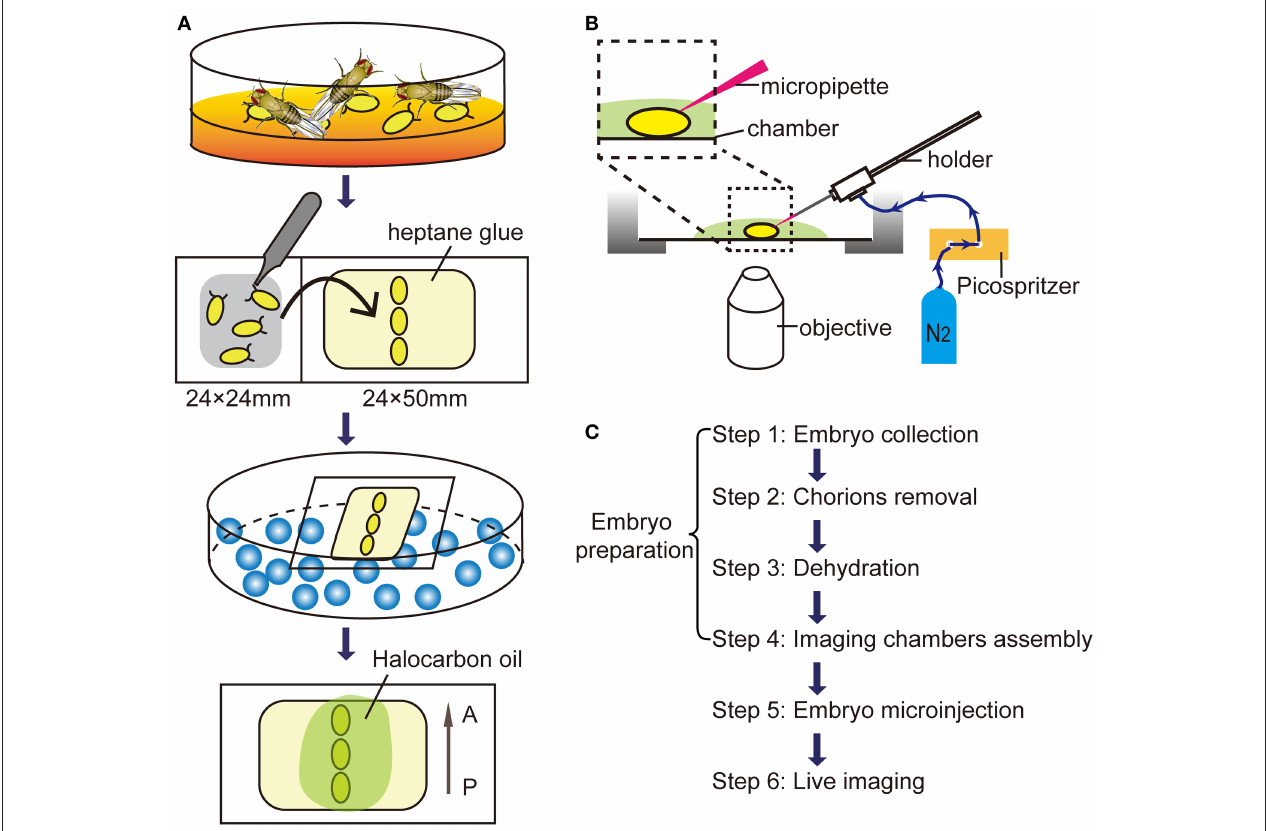
FIGURE 1 | Microinjection procedures for in vivo imaging. (A) The schematic diagram of embryos preparation. A, anterior; P, posterior. (B) The diagram of the microinjection system. (C) The flow diagram for live imaging of macropinocytosis in embryonic